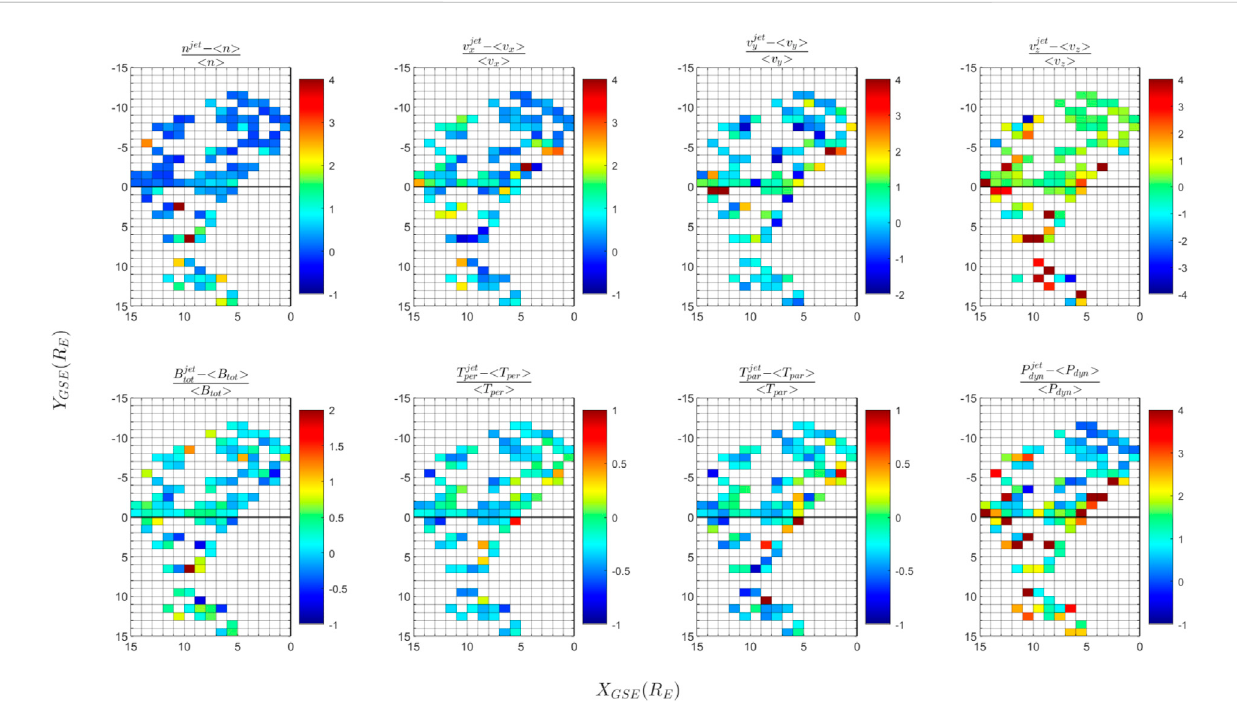
FIGURE 5 Relative perturbation of the background magnetosheath state produced by jets, for data recorded in 2007. We illustrate the same set of plasma variablesasinFigure4.Thevalueoftherelativeperturbationiscolorcodedasshowninthetablesnexttothepanels.TheperturbationofthevariableQis estimated as the ration Q jet − 〈 Q 〉 〈 Q 〉 , where Q jet is the value assigned to the jet and < Q > is the background value. < Q > is evaluated as the average between two time intervals, Δ t1 equal to 1 min preceding the detection of the jet, and Δ t2 equal to 30 s after the last point included in jet.